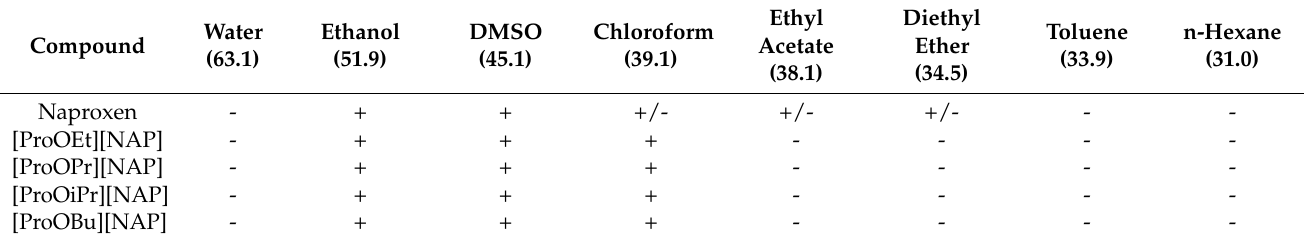
Table 4. Solubility in water and organic solvents of naproxen and L-proline alkyl ester naproxenates at 25 ◦ C.